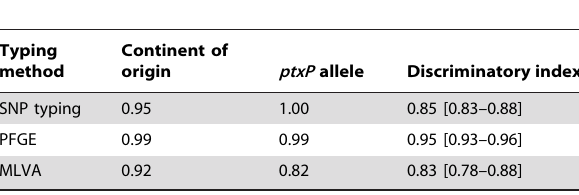
Table 1. Wallace coefficients and Discriminatory indices.